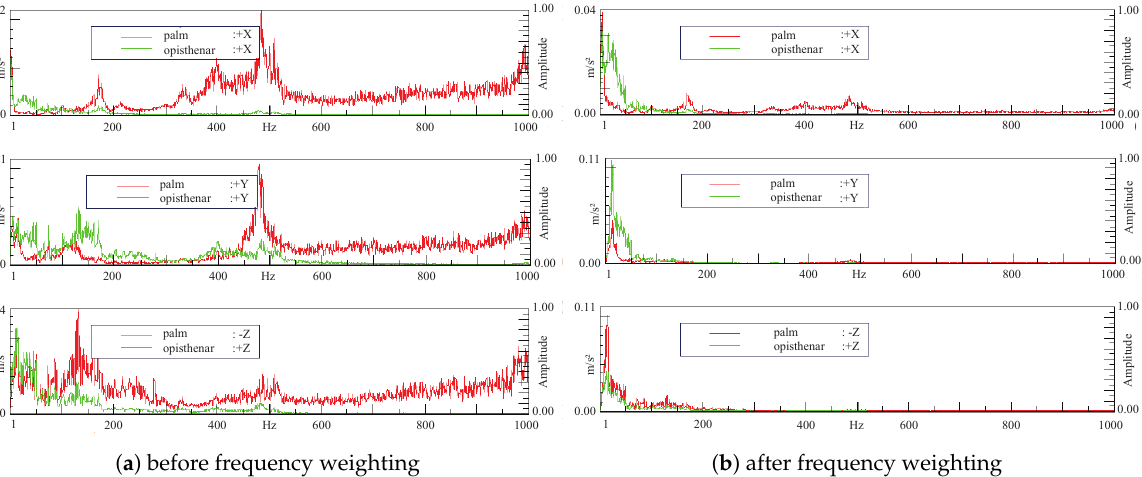
Figure 7. Comparison of the three-axis test signals’ filter spectrogram of the power tool using a 400 mm operating rod with bare